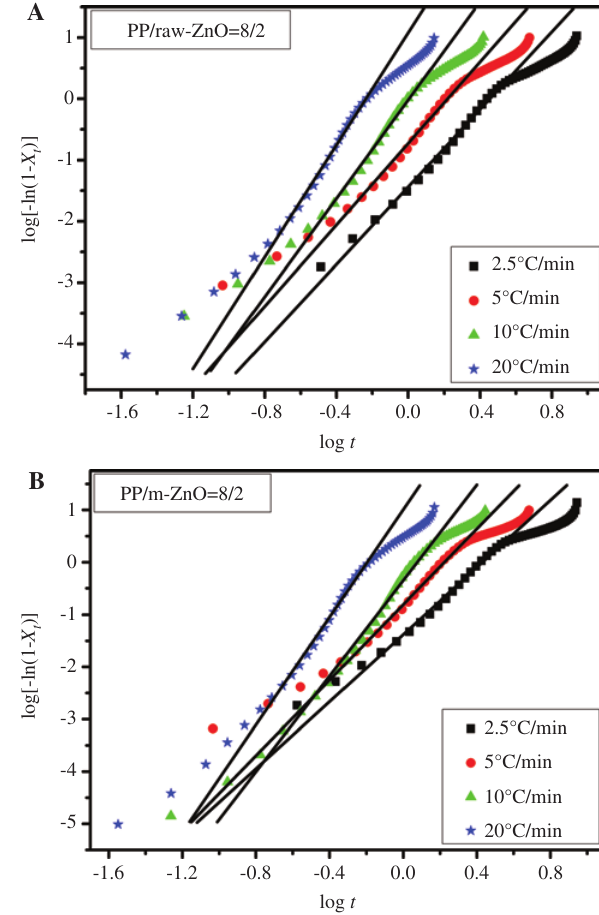
)] versus log t of the PP/ZnO Figure 4 Curves of log[-ln(1- X t composites at the indicated cooling rates; (A) PP/raw-ZnO and (B) PP/m-ZnO.